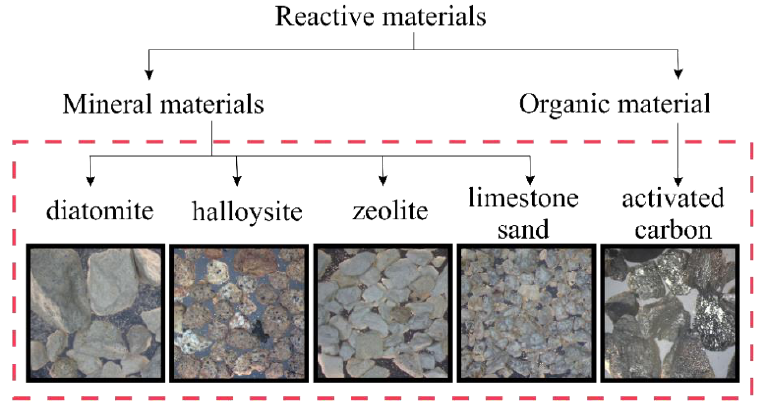
Figure 1. Reactive materials used in the studies.